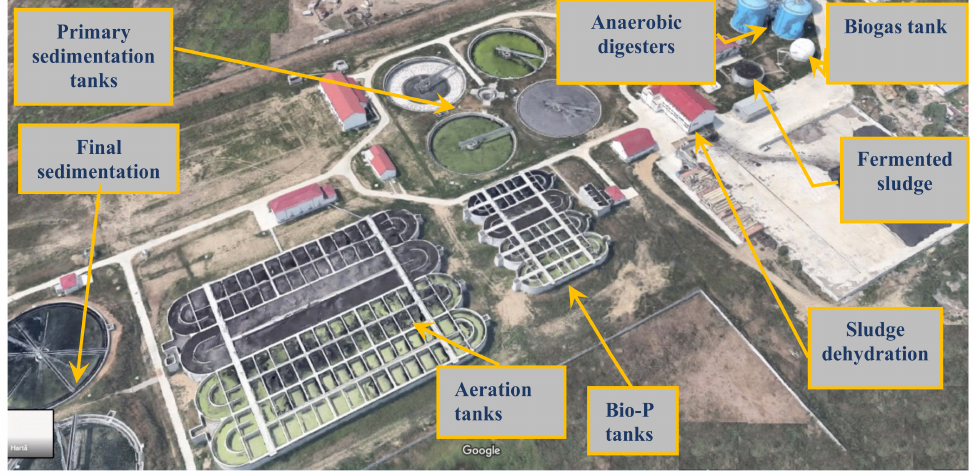
Figure 2. An aerial view of the WWTP F ă c ă i, Romania [5].